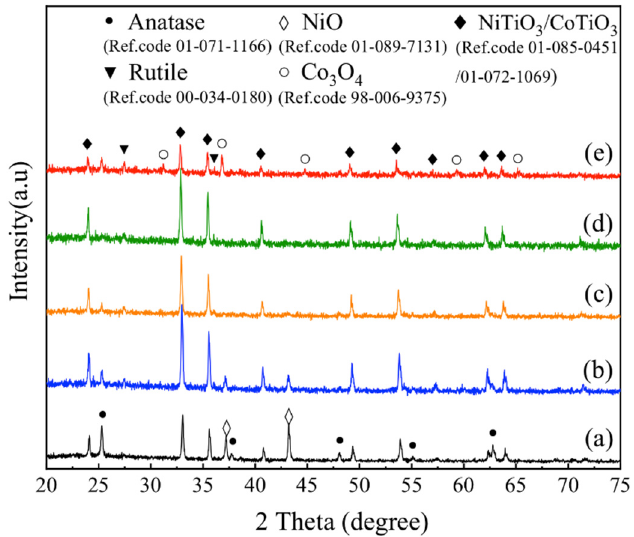
Figure 2. XRD patterns of the products after calcination at 800 °C for samples with different Co/Ni molar ratios: ( a ) 0.1:0.9, ( b ) 0.3:0.7, ( c ) 0.5:0.5, ( d ) 0.7:0.3, ( e ) 0.9:0.1.